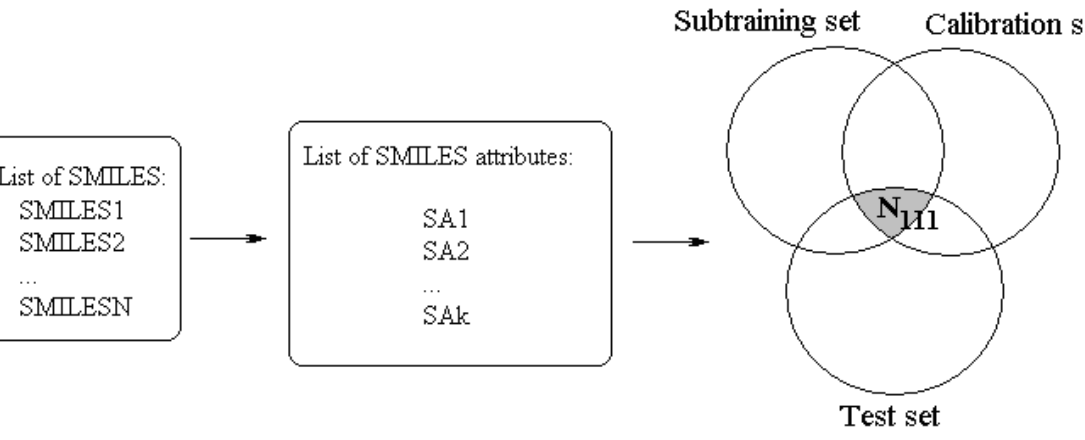
Figure 1. General scheme of construction of the optimal SMILES-based descriptors by means of the correlation balance